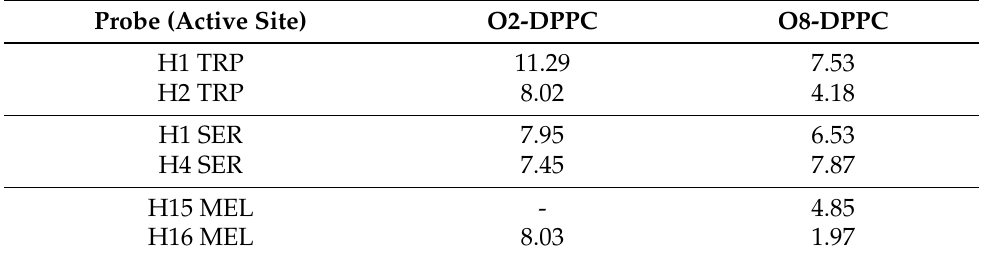
Table 2. Free energy barriers ∆ F (in kJ/mol) for the binding of small molecules to DPPC. Probe (Active